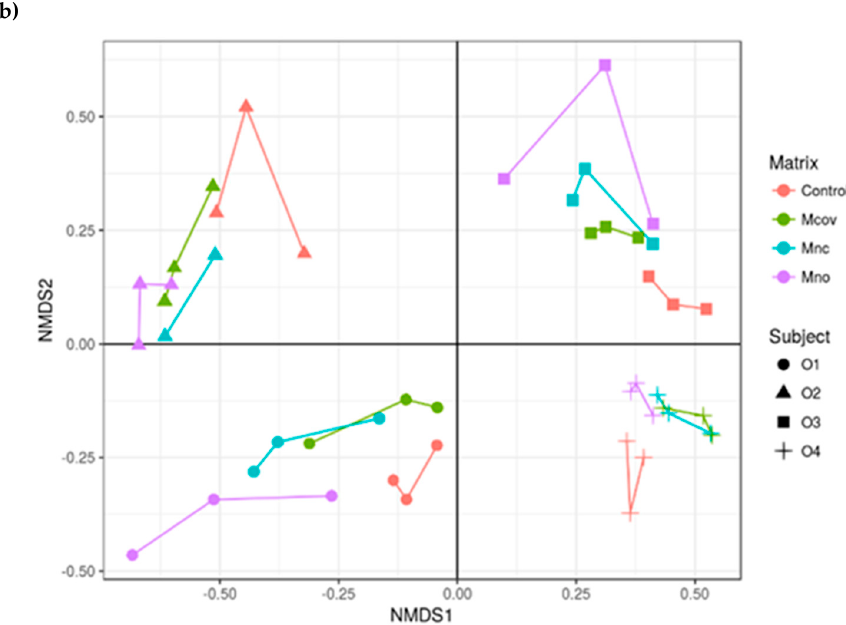
Figure 6. Genus-level relative bacterial composition of fecal slurries at the initial time point of fermentation (Control) and after 48 h fermentation of the three apple matrices (Mcov, Mnc, Mno). ( a ) Relative abundances of the top 23 classified genera sorted by phylum are depicted, with the genera represented by less than 5000 reads pooled into “Others”. ( b ) Genus-level bacterial community variation represented by Non-metric MultiDimenstional Scaling (Bray-Curtis dissimilarity). Samples ( n = 47) were colored and shaped according to experimental conditions (Control + Matrices) and subject, respectively. The analysis of variance using distance matrices gave a R-squared of 0.08 in response to matrix and a R-squared of 0.66 in response to subject ( p value < 0.0001).